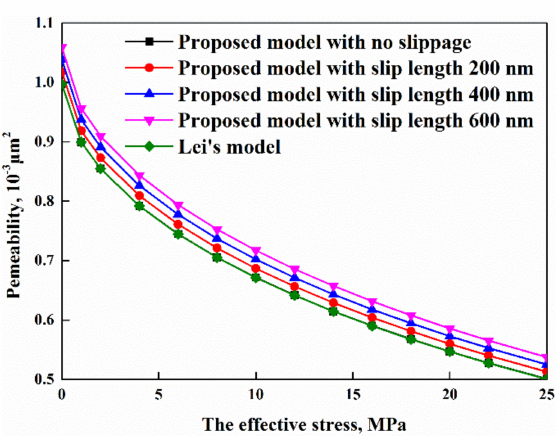
Figure 4. The comparison between the results of our model and that of Lei’s model [32].